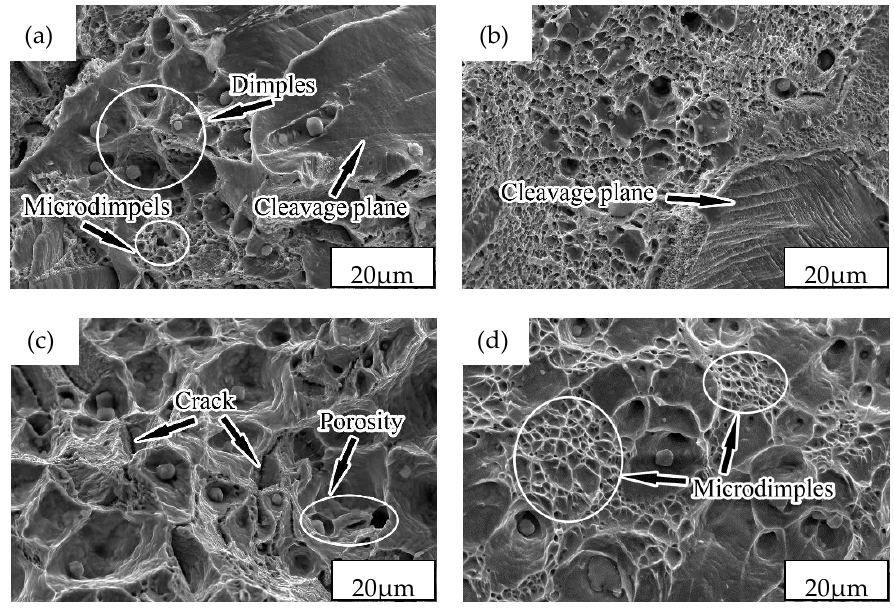
Figure 7. Fracture morphologies of NSSC 2120 after aging at different temperatures: a ) SX-650; b ) SX-750; c ) SX-850; d ) SX-950.